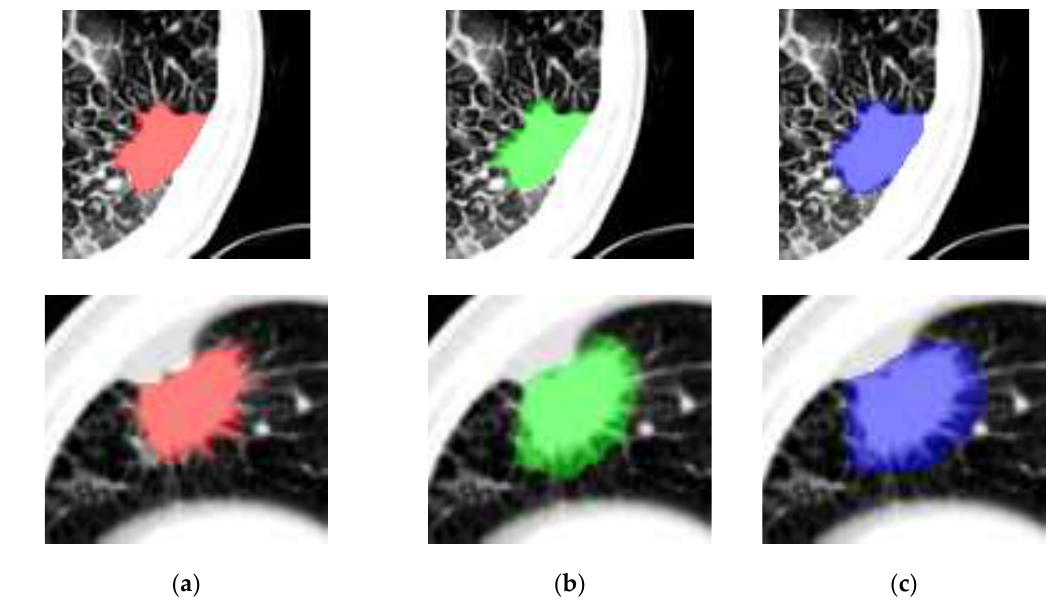
Figure 1. Illustrative examples of manual segmentations. For each patient on a row, different segmentations are showed superimposed on CT data: ( a ) polygonal, ( b ) free-hand accurate and ( c ) free-hand rough.